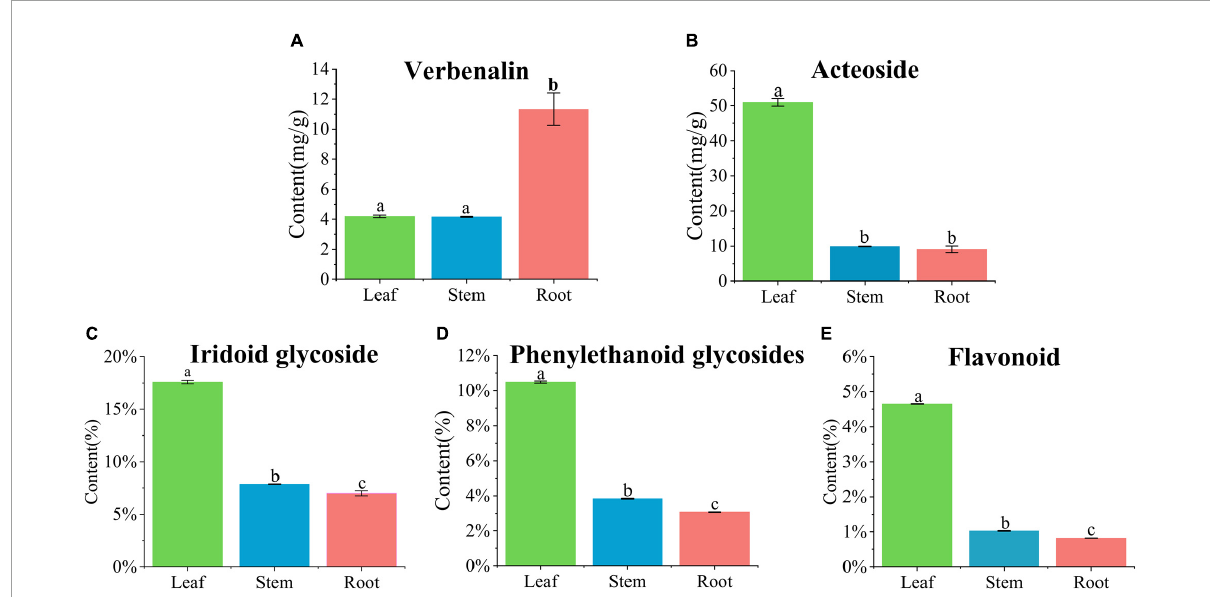
FIGURE7 Quantification in the leaf, stem, and root of Verbena officinalis . (A) Verbenalin. (B) Acteoside. (C) Total iridoid glycosides. (D) Total phenylethanol glycosides. (E) Total flavonoids. Values are expressed as the means ± standard errors of three independent samples. Significant differences ( p < 0.05) were analyzed using Origin2021 and indicated by lowercase letters a, b, and c in the leaf, stem, and root.